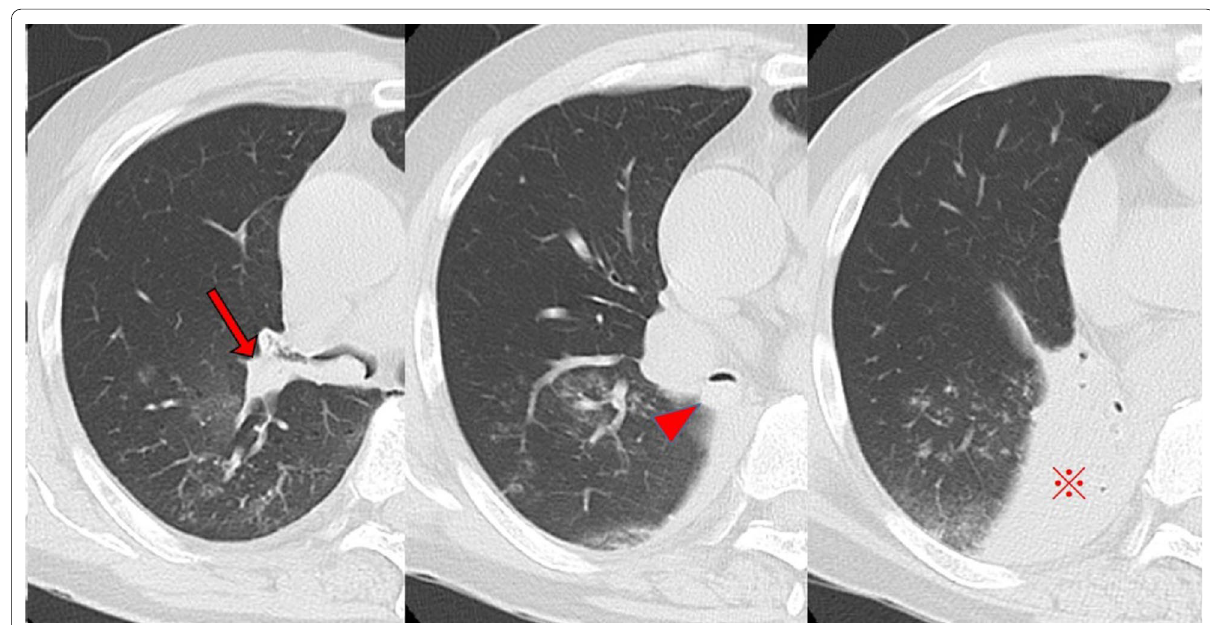
Fig. 2 Intratracheal obstruction due to hematoma from the upper lobe bronchus (arrow) to the middle bronchial trunk (arrowhead). The right middle and lower lobes (